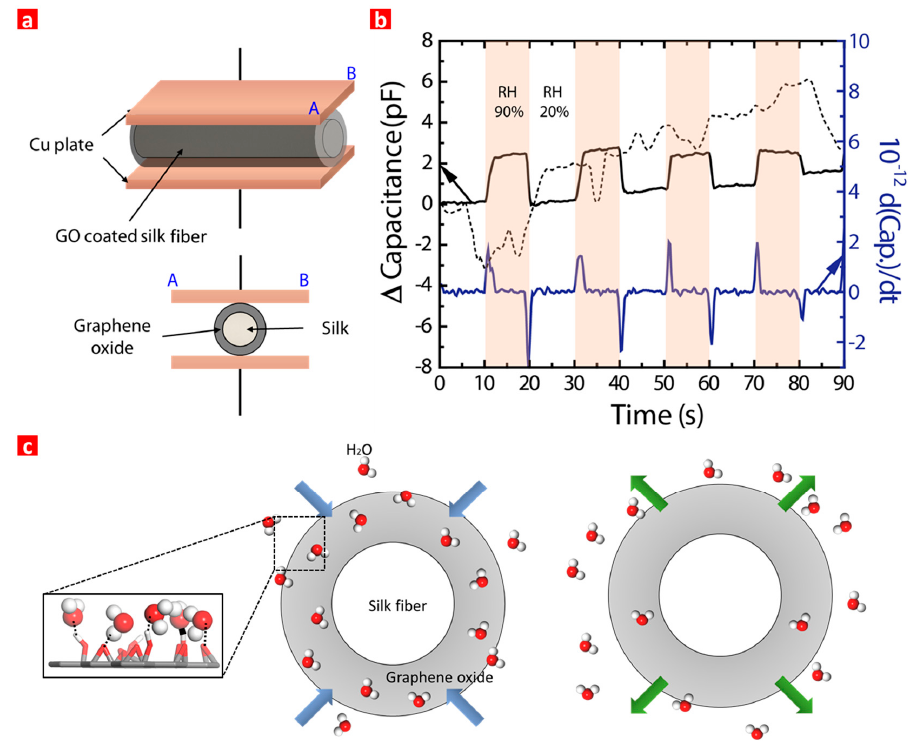
Figure 4. ( a ) Schematic image of capacitive humidity sensor where GO coated SF was implemented. The average diameter of SF is 0.17 cm; ( b ) The capacitance and its derivative curve of the sensor when the humidity changed between 20% RH and 90% RH. The dot represents the intact silk between the two cu plates; ( c ) Schematic image of H 2 O absorption (RH 90%) and desorption (RH 20%) characteristics on GO coated SF.